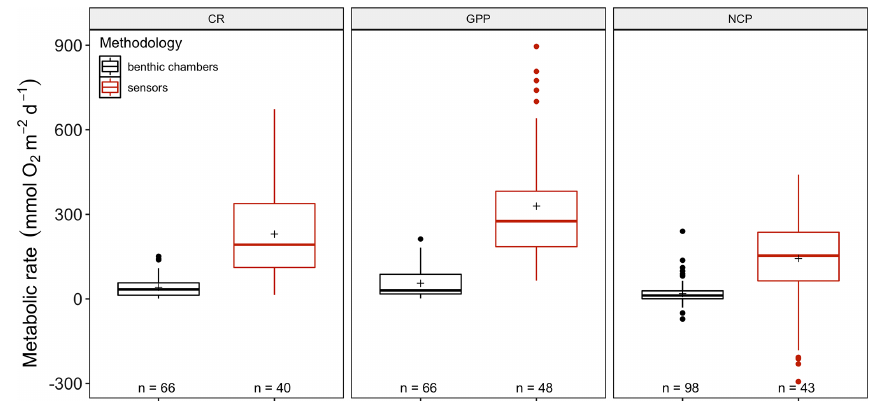
Figure 2. Comparison between benthic-chamber (black) and sensor data (red) for CR, GPP and NCP (mmolO 2 m − 2 d − 1 ) for the full dataset. Upper and lower hinges correspond to the upper and lower quartiles; the line inside the boxes corresponds to the median; the mean is marked by a crosshair; and the error bars are based on minimum and maximum standard deviation for each parameter. We found differences ( p > 0 . 01) in metabolic rates between methods for CR, GPP and